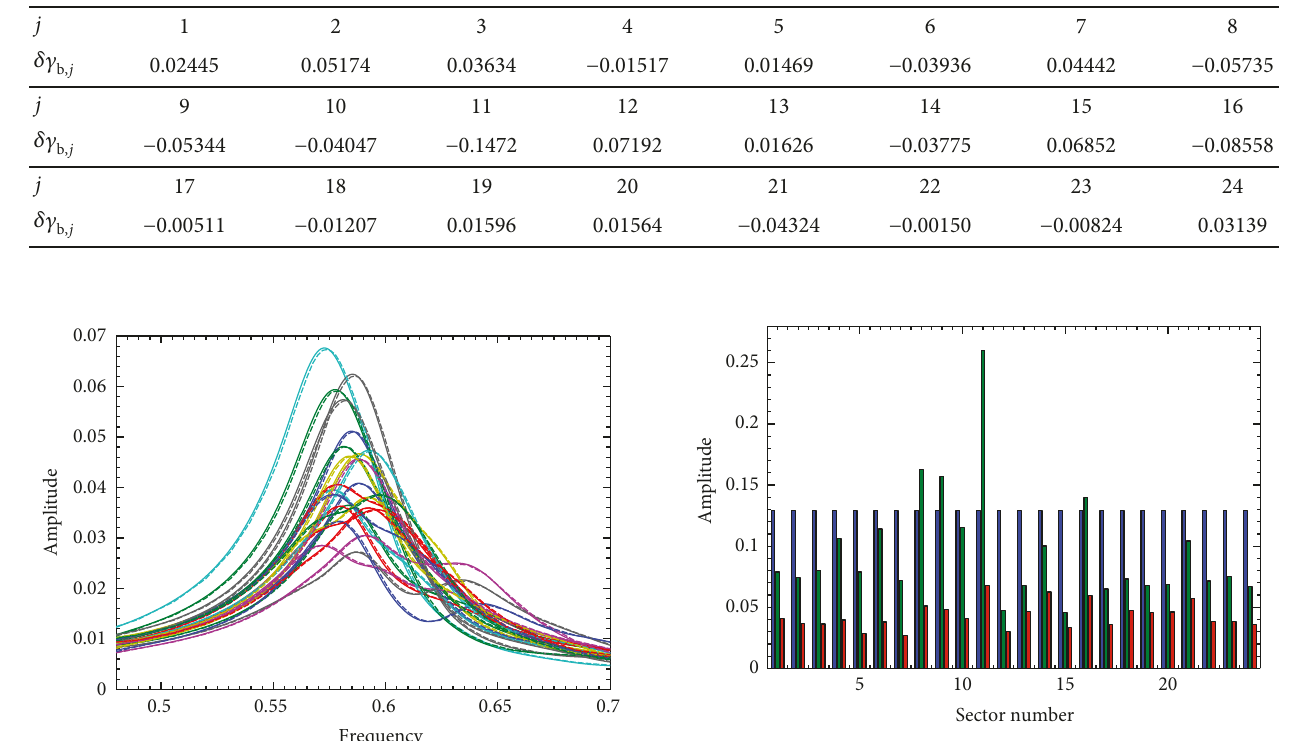
Table 3: Mistuned sample of the blade sti ff ness.